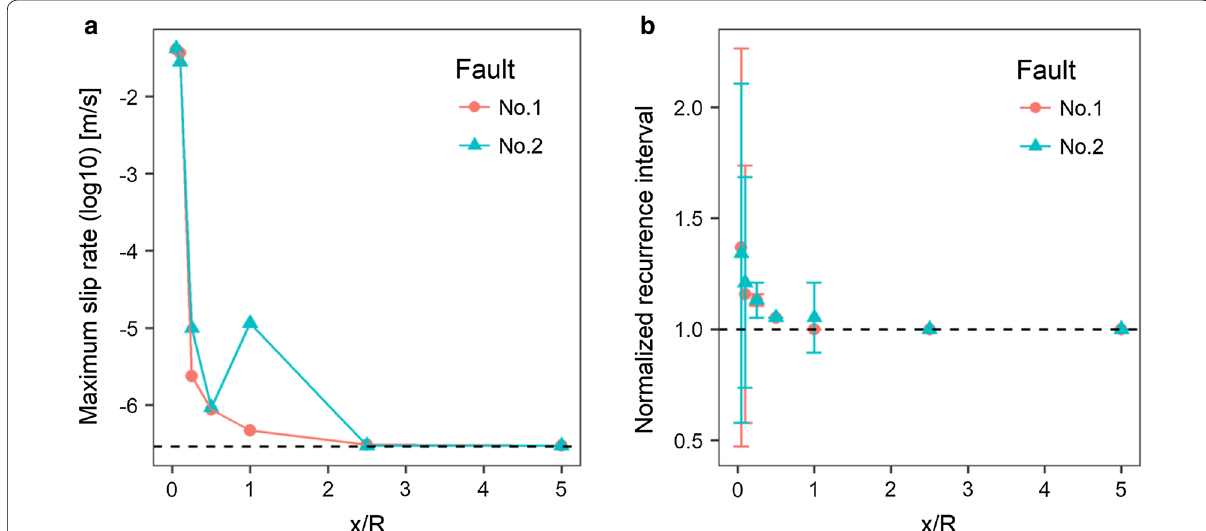
Fig. 5 Effects of the inter-fault distance x / R in Case 2 with the aging law. a Maximum slip rates at the fault centers. The horizontal broken line means the result for a single fault. b Event recurrence intervals normalized by that for a single fault (horizontal broken line). The vertical bars represent